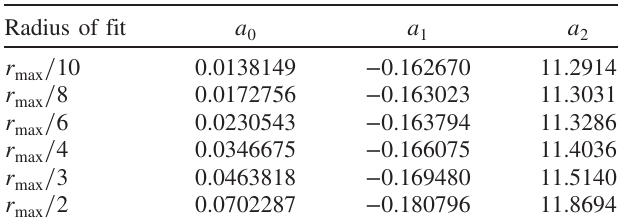
TABLE II. Parameters for a fit of an Enge function of the form (63), to the quadrupole gradient in an EMMA F quadrupole. The maximum radius r in the field data is 36 max